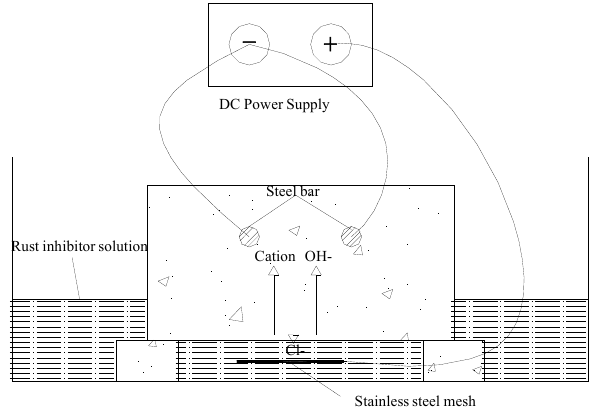
Figure 5. Principle underlying bidirectional electromigration rehabilitation.